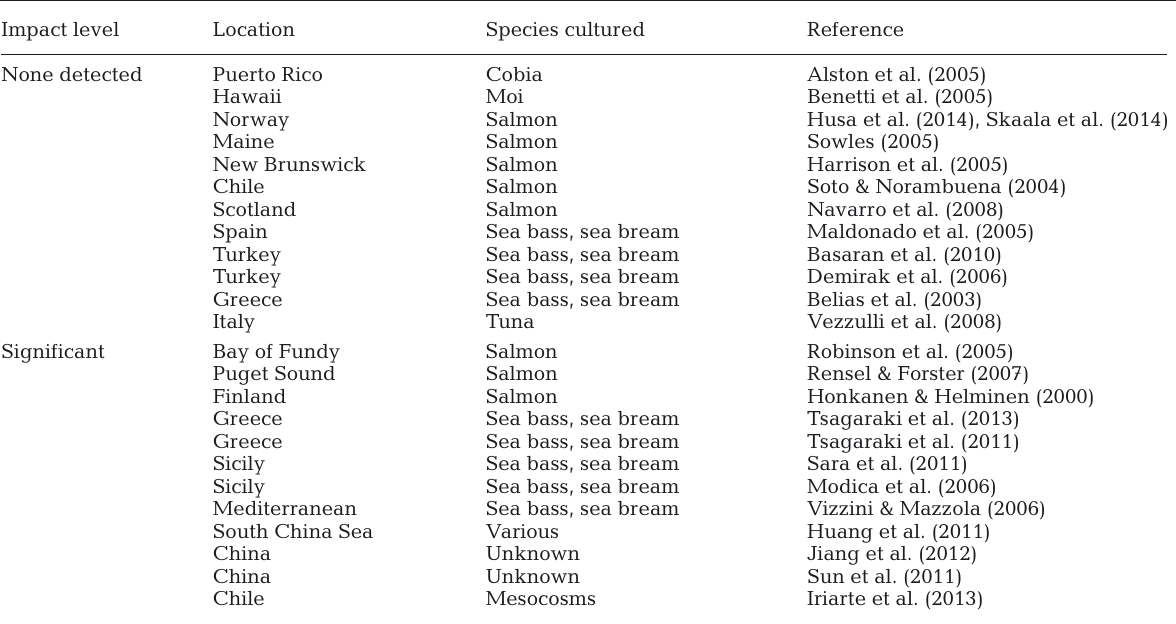
Table 5. Summary of primary production effects reported and modeled at fish cage sites in response to farm nutrient